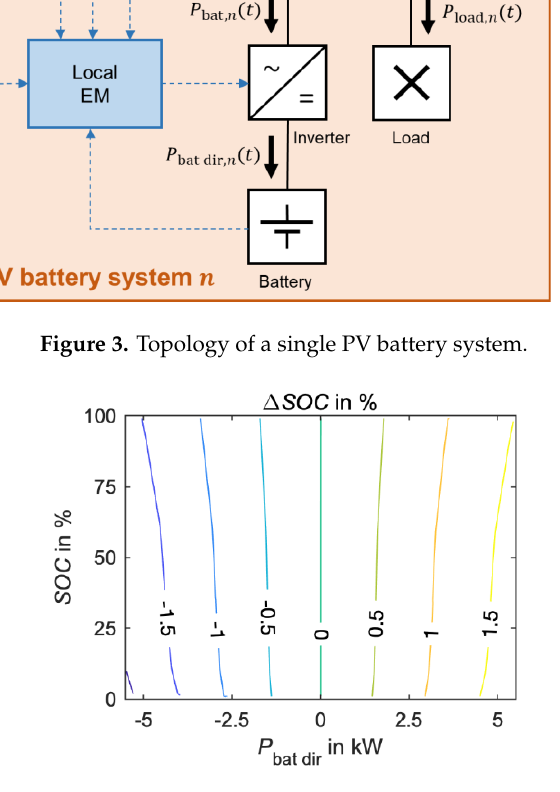
Figure 4. Characteristic map of the battery (1 min charging/discharging).